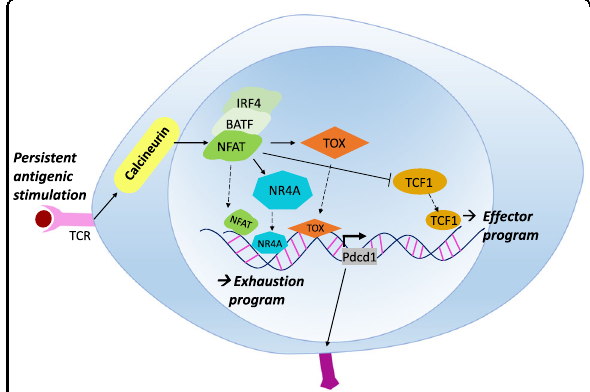
Fig. 3 Transcriptional regulatory network of exhausted CD8 +